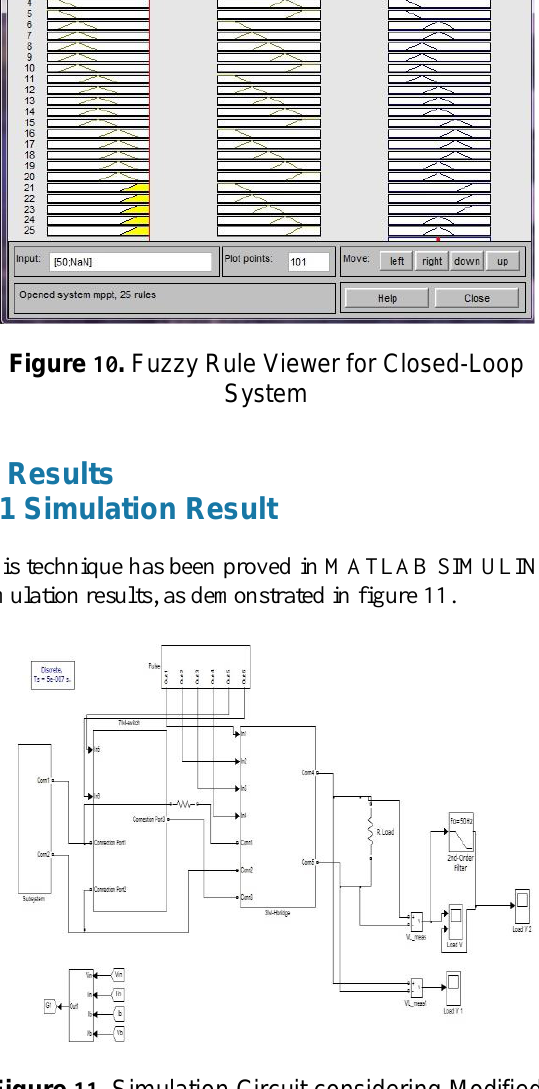
Figure 11 . Simulation Circuit considering Modified H-Bridge Seven Level Inverter